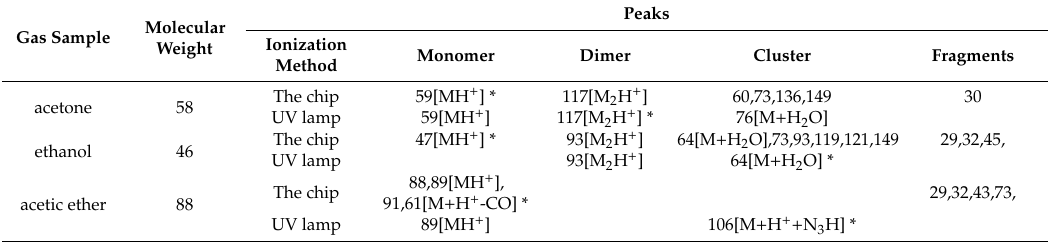
Table 1. Ion species in mass spectra obtained by the needle-cylinder chip and UV lamp.